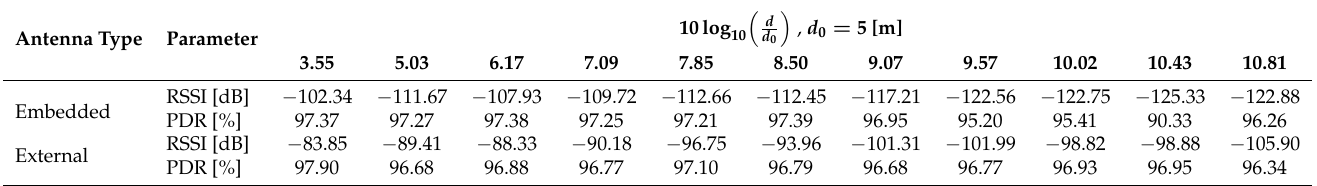
Table 4. Measured average of received power and Packet Delivery Ratio for Non Line-of-Sight scenario (one turn).